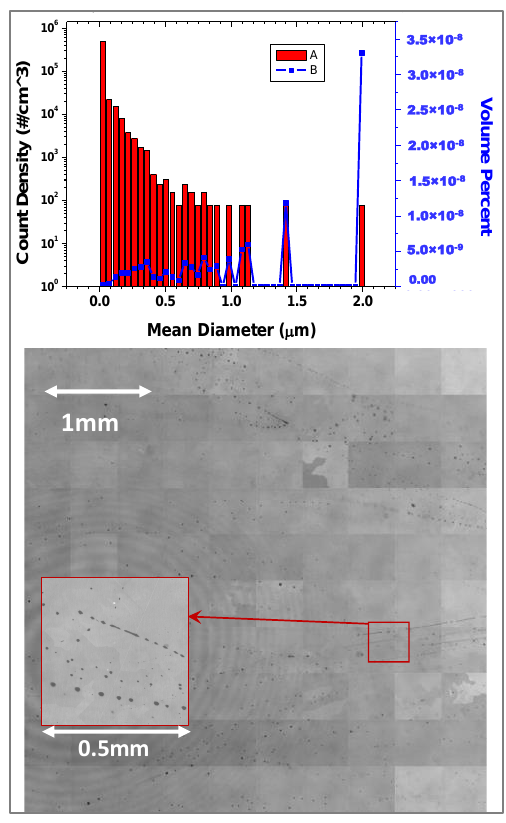
Figure 6. CRY-4, a 5 × 5 mm 2 , multi grain sample; ( top ) Te inclusions with average density ~5.5 × 10 5 cm −3 and size ~0.02 µm. ( bottom ) 2d- IR image with an inset showing inclusions’ alignment.